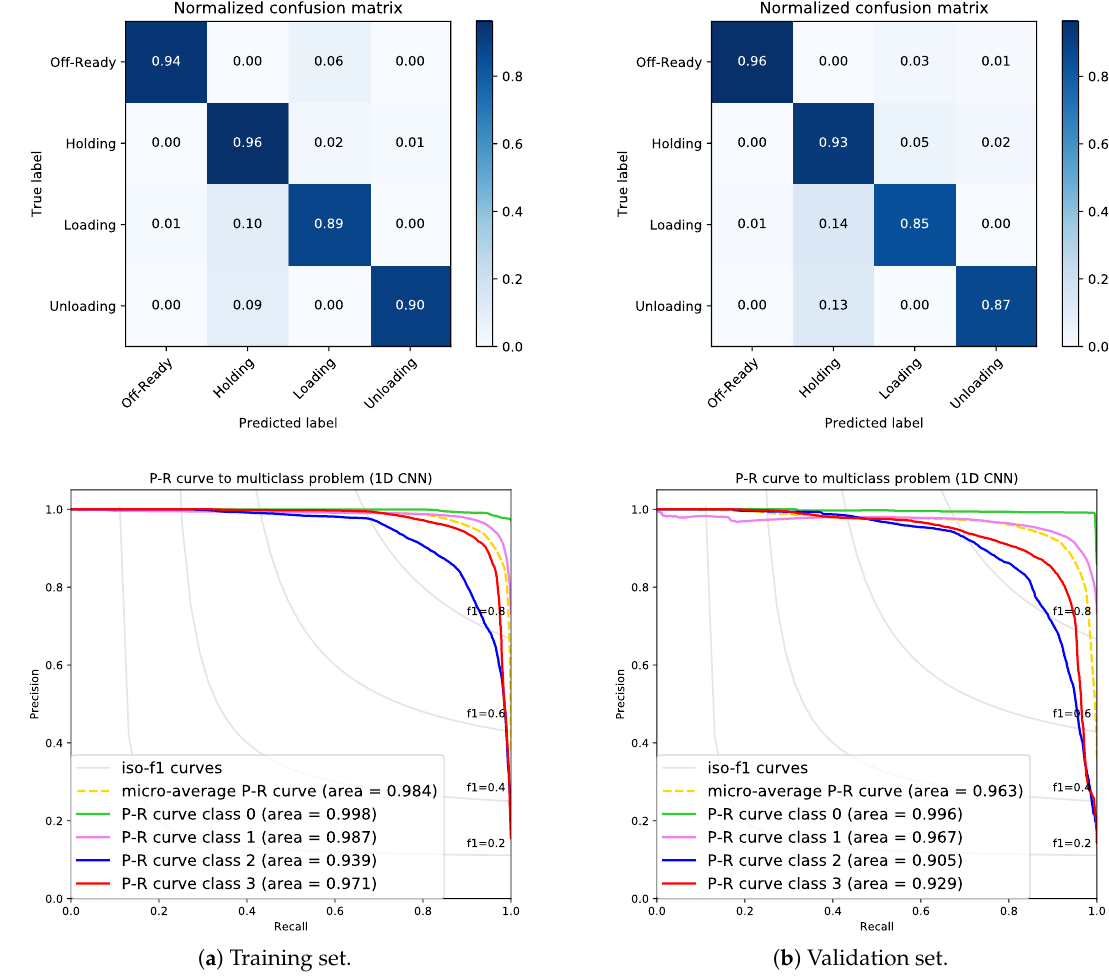
Figure 6. Confusion matrices and prediction–recall curves (PR) curves using sensor data from compressor 3.